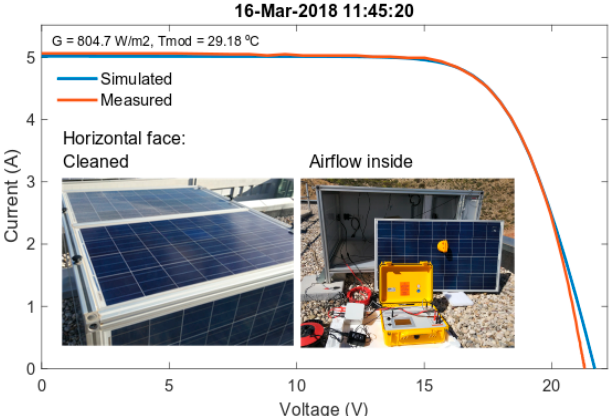
Figure 4. Measured and simulated I-V curve for the horizontal face when the PV module was cleaned and one face was opened, allowing airflow inside of the structure. The measured I-V curve was obtained by the I-V tracer PVPM 1000CX. The simulated curve, solving the single-diode equation through toolbox, was developed by Sandia National Laboratories, using a PVSyst model and setting as inputs the in-plane irradiance, module temperature, and specifications given by the PV module manufacturer at standard test conditions. Further details about the toolbox and modeling functions can be found in [30,31].